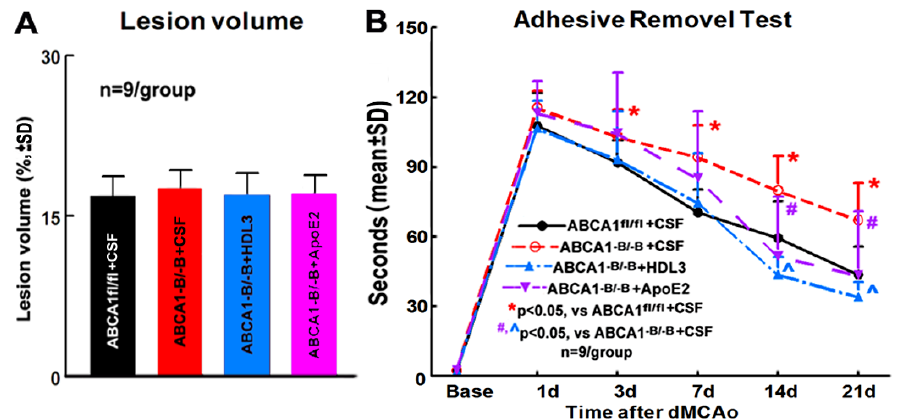
Figure 2. ABCA1 -B/-B stroke mice significantly decreases functional outcome compared to ABCA1 fl/fl stroke mice administered with cerebrospinal fluid (CSF); administration of high-density lipoprotein (HDL)3 or apolipoprotein E (ApoE)2 in ABCA1 -B/-B stroke mice advertises ABCA1 -B/-B -induced functional deficit after stroke. ( A ) Quantitative data of lesion volume. ( B ) Quantitative data of the adhesive removal test. * p < 0.05, vs. ABCA1 fl/fl stroke mice; #, ^ p < 0.05, vs. ABCA1 -B/-B stroke mice; n = 9/group.